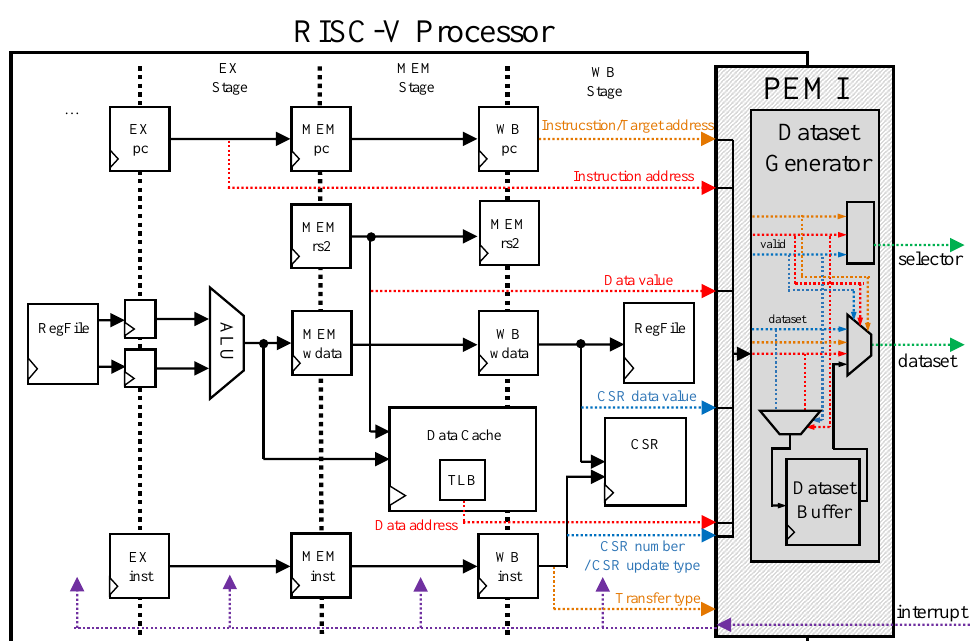
Figure 2. Microarchitecture of PEMI